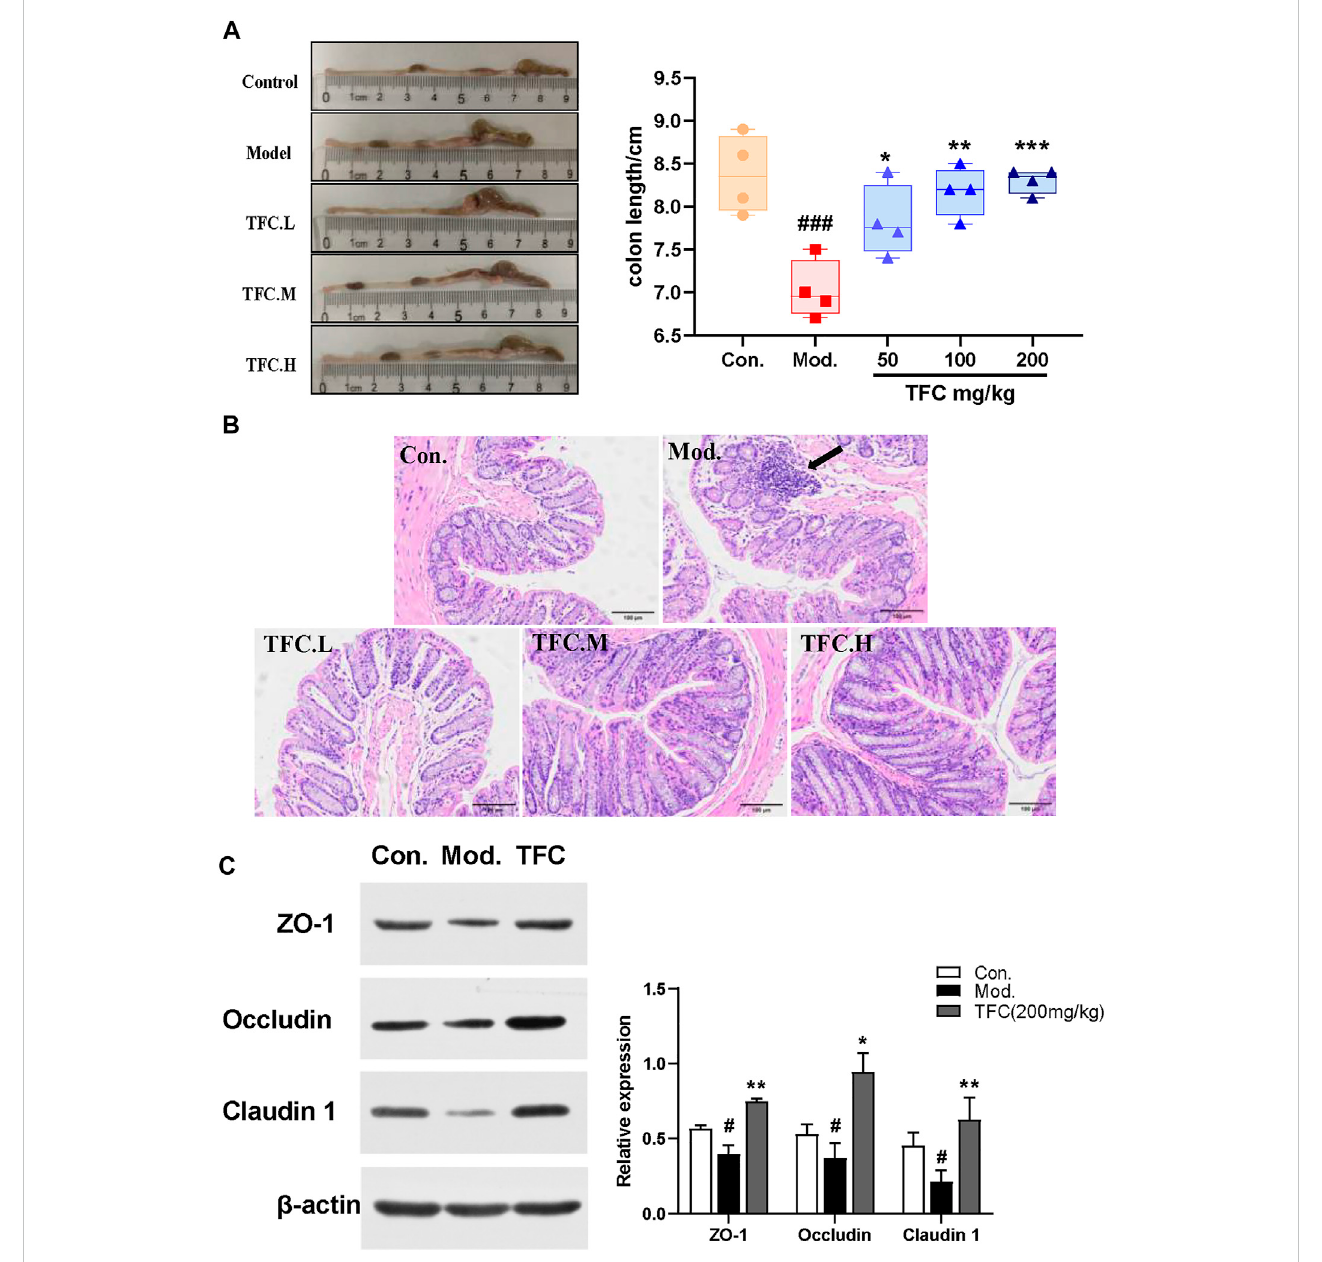
FIGURE 7 TFC attenuates intestinal damage caused by alcohol intake (A) Representative images of colon morphology and length (B) histological changes of liver sections measured by HE staining at ×200 magni fi cation (C) the representative blots of relative ZO-1, Occludin and Claudin one in the colon with β -actin as a loading control; Data are expressed as mean ± S.D. # p < 0.05, ## p < 0.01, ### p < 0.001 vs. control group;* p < 0.05, **p < 0.01, ***p < 0.001vs. model